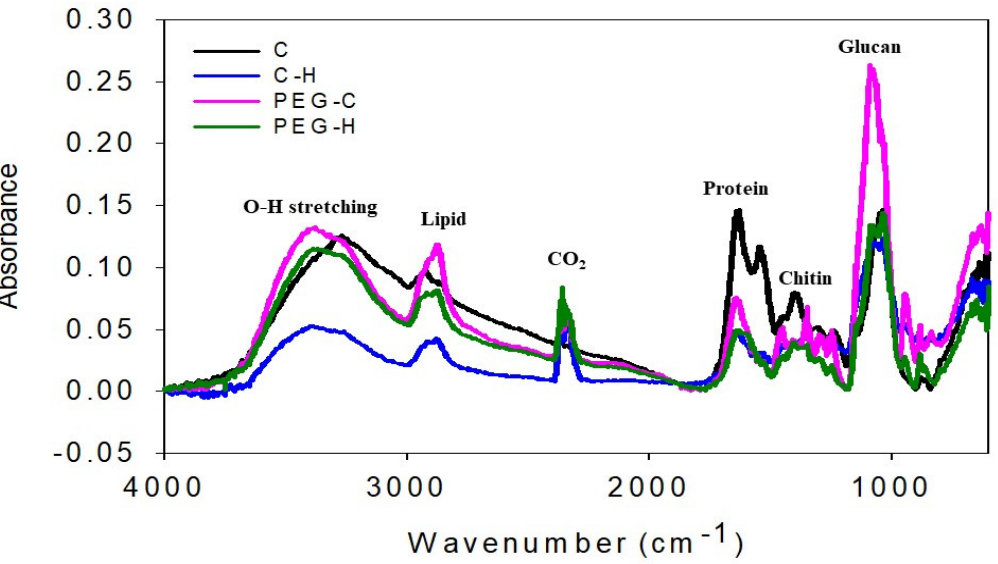
Figure 5. FTIR spectra of MBLs, showing those of the control samples and pretreated MBL samples. The main absorption bands indicating the mycelial cell-wall components are the asymmetric and symmetric vibration O-H stretching, demonstrating a high glucan content. The major absorption bands and their principal groups are labeled. As PEG-C samples exhibit a chemical effect, a difference between the plasticized MBLs, the hotpress control, and treated samples can be observed.